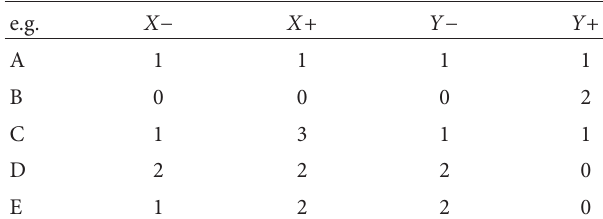
Table 1: The number of Points of